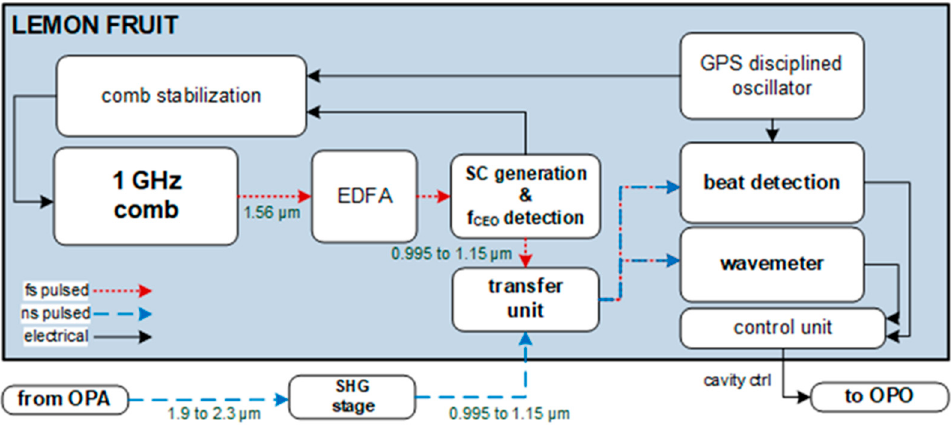
Figure 16. Schematic of the frequency reference unit (FRUIT).